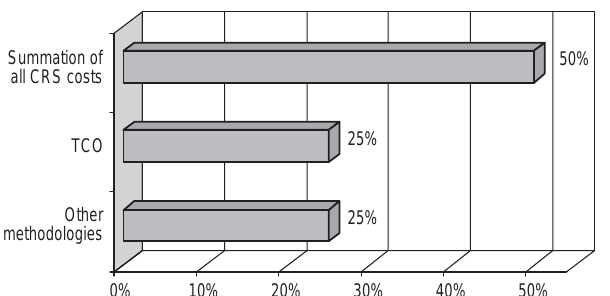
Fig. 1. CRS cost calculation methodologies used in Lithuanian companies